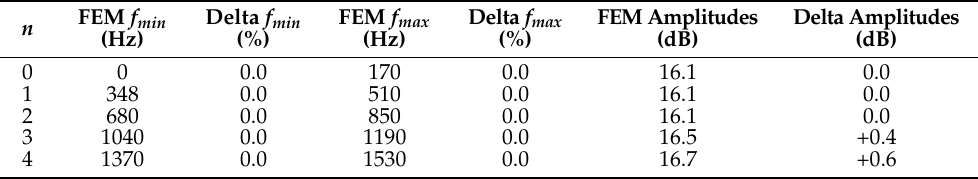
Table 5. Comparison between analytical and FEM data of simple expansion chamber without discontinuity.